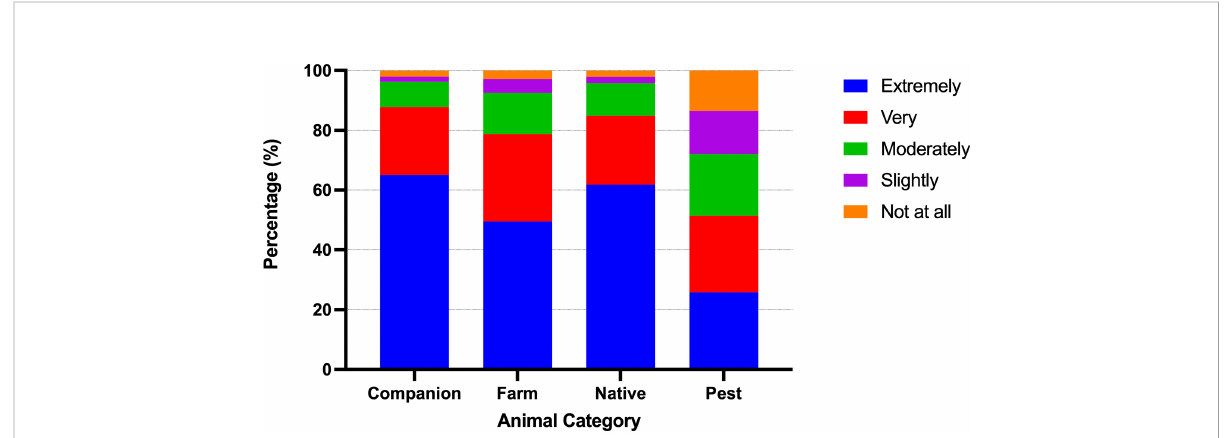
FIGURE 2 Percentage ranking of importance for the legal system to take cruelty seriously based on animal species involved (n=2152). “ How important do you think it is for the legal system to take animal cruelty seriously when the animal is a [companion, native, farm, or pest animal]? ”